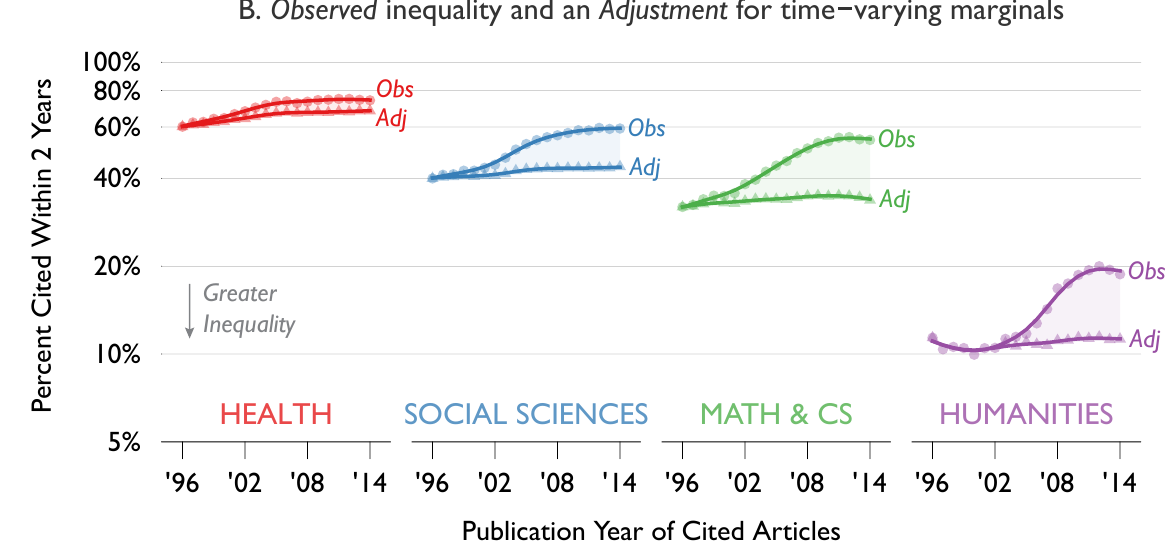
Figure 4: Percentage of articles with any citations two years after publication, 1996–2014: Monte Carlo simulation and empirical results. The lines in the top panel marked Sim show percentage of articles ever cited from Monte Carlo results for hypothetical articles and citations designed to have a fixed pattern of inequality across years and fields, but total articles and citations matching the empirical marginals of those fields by year. The lines marked Cor remove the marginals bias in percentage-ever-cited using a resampling correction. The lines marked Obs in the bottom panel shows percentage-ever-cited over fields and time using the empirical data from Web of Science; these results are subject to marginals bias from differences in total articles and citations by field and year. Lines marked Adj adjust for marginals bias in the empirical data by resampling to the marginals in 1996 by field. Corrections and adjustments omitted for the humanities in 1997–2002. All curves are smoothing splines with a span of 0.5. One exceptionally highly cited article in mathematics and computer science is